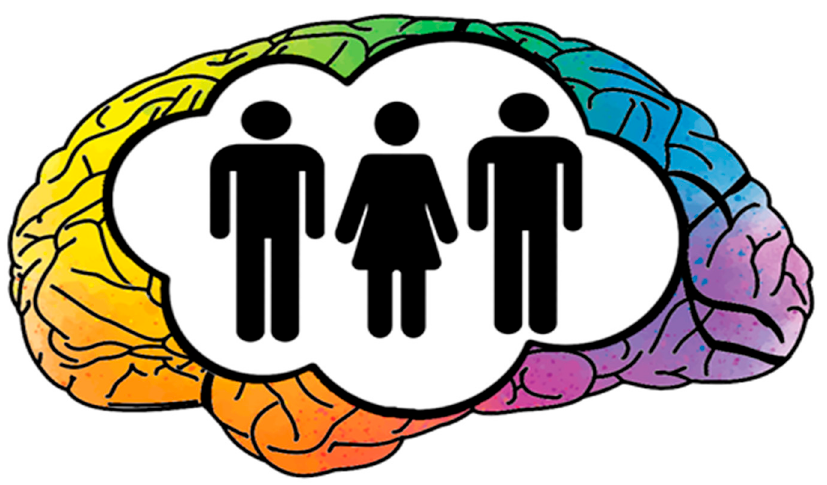
Figure 1. Residing Voices in the Brain.